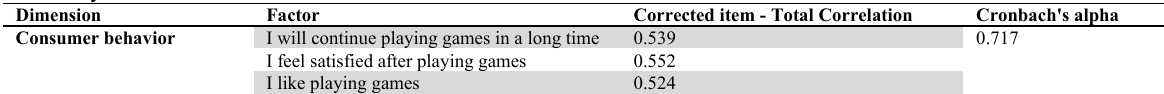
Source: Survey data